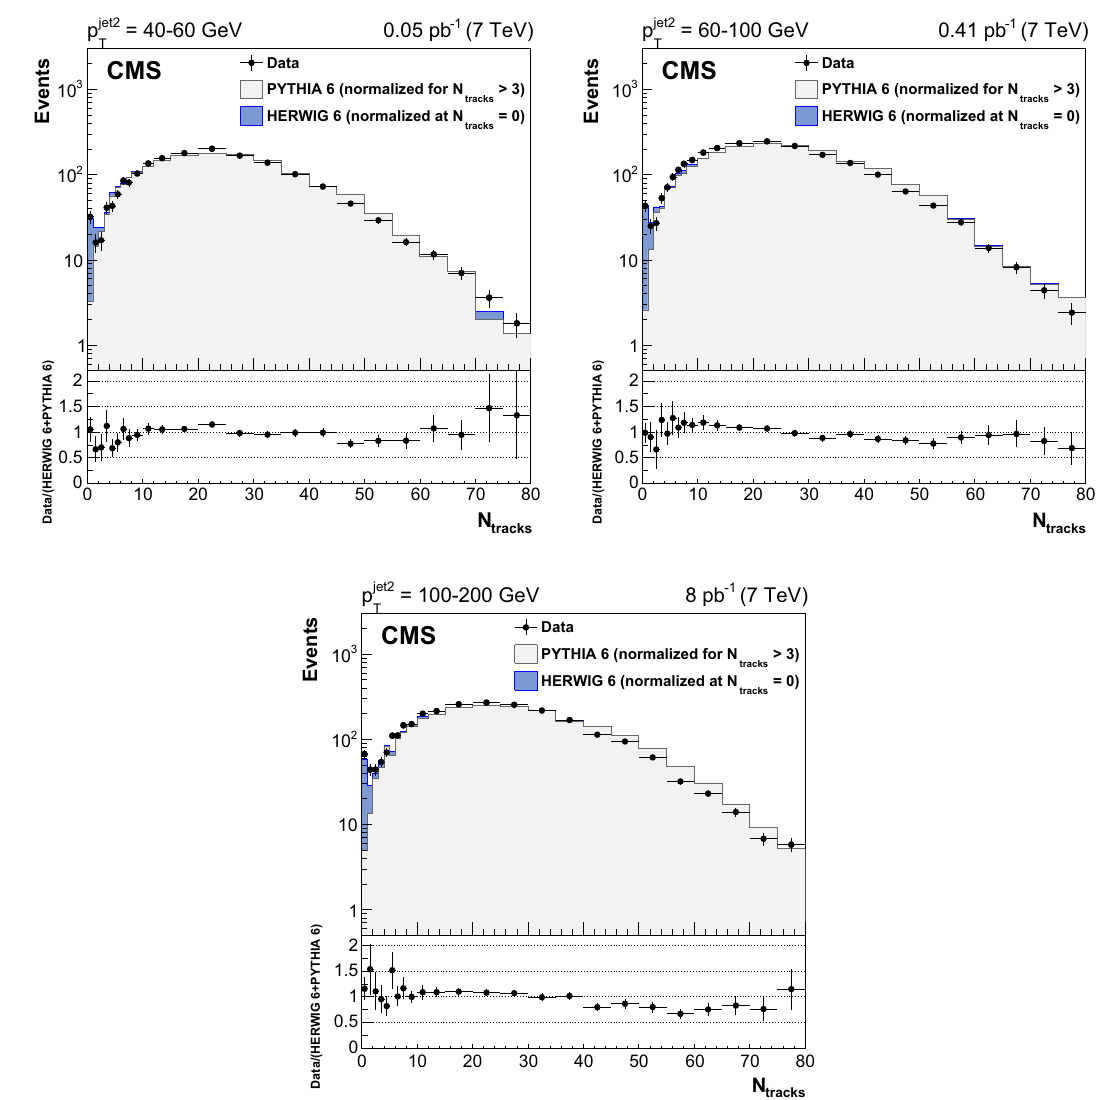
Fig. 3 Distribution, uncorrected for detector effects, of the number of central tracks between the two leading jets in events with p jet2 (top left), 60–100 (top right), and 100–200 (bottom) GeV, compared to the predictions of pythia 6 (inclusive dijets) and herwig 6 (CSE jet-gap-jet events). The pythia 6 and herwig 6 samples are normal-